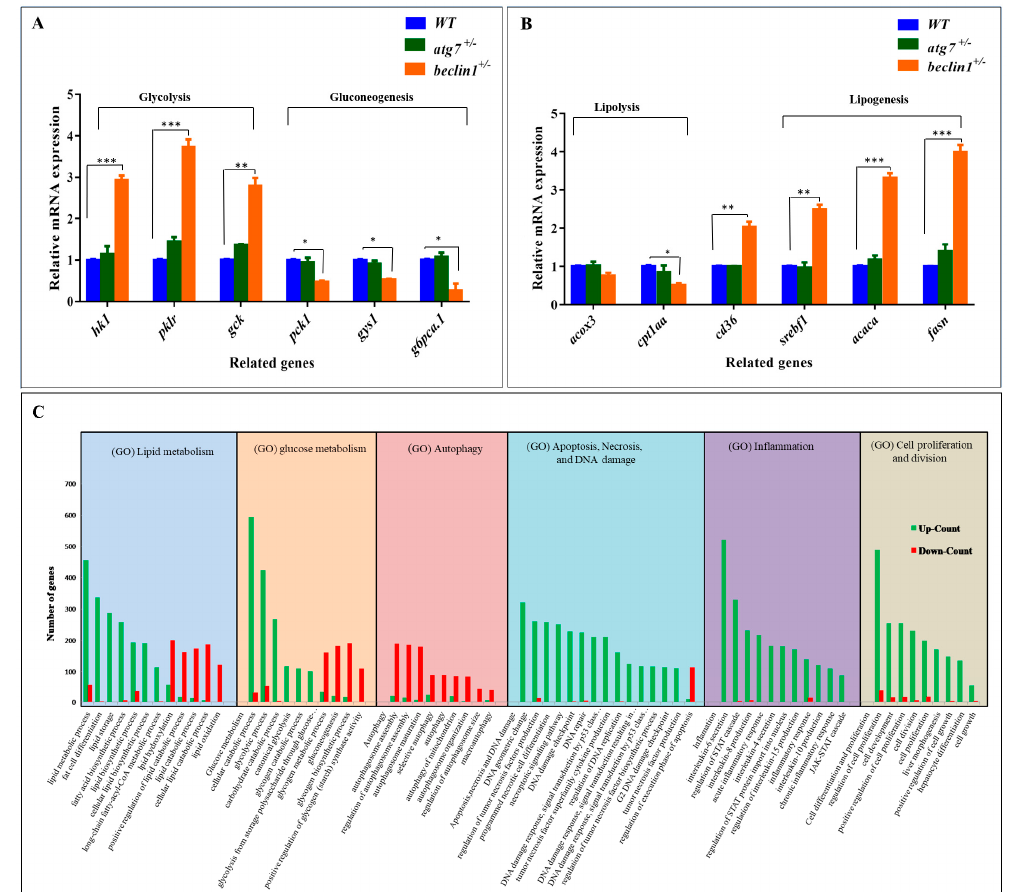
Figure 4. Effects of beclin1 heterozygosity on the hepatic glucose/lipid flux at the genetic level. Expressions of mRNA in 16-month-old zebrafish evaluated by qRT-PCR for glycolysis and gluconeogenesis related genes ( A ) and lipolysis and lipogenesis related genes ( B ) indicating the disturbance of glycogen and lipid metabolism. ( C ) Gene Ontology (GO) analysis of differential expression genes (DEGs) in the liver between beclin1 +/ − and WT. The y -axis represents the number of genes of the biological processes in the x -axis. The numbers of upregulated DEGs (green bars) and downregulated DEGs (red bars) are shown. Data are expressed as mean ± SD. * p < 0.05, ** p < 0.01, and *** p <